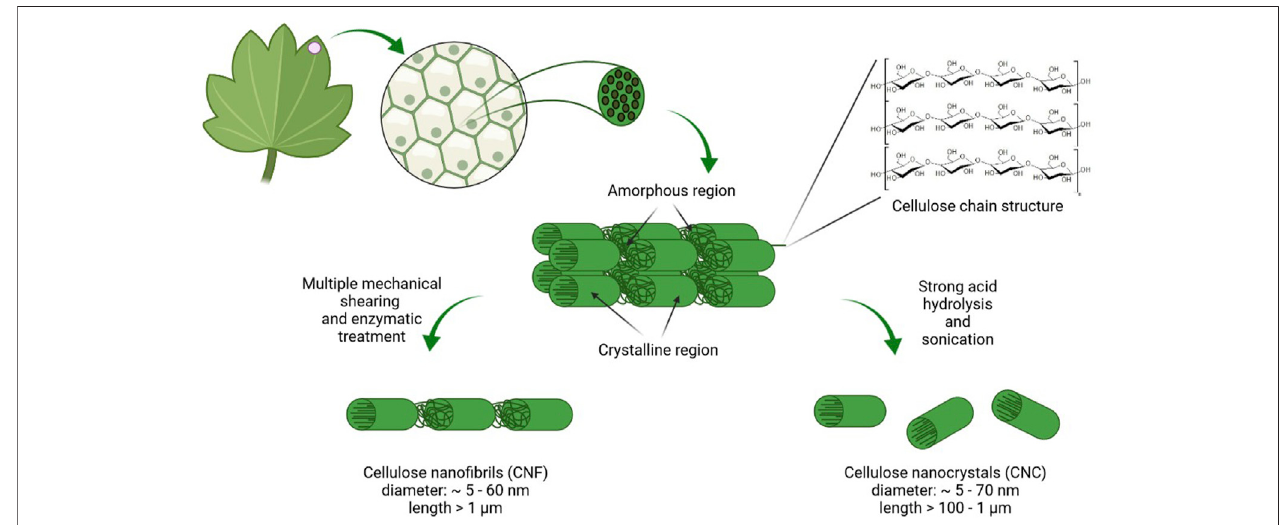
FIGURE4| Schemeofplant nanocellulose origin, composition, and organization. Cellulose inplant cells wall isorganized intomicro- and macro fi brilles. During the puri fi cation process lignin and hemicellulose are removed. Acid hydrolysis leads to formation of highly crystalline CNC while NFC is prepared by disintegration with high shear forces (created in